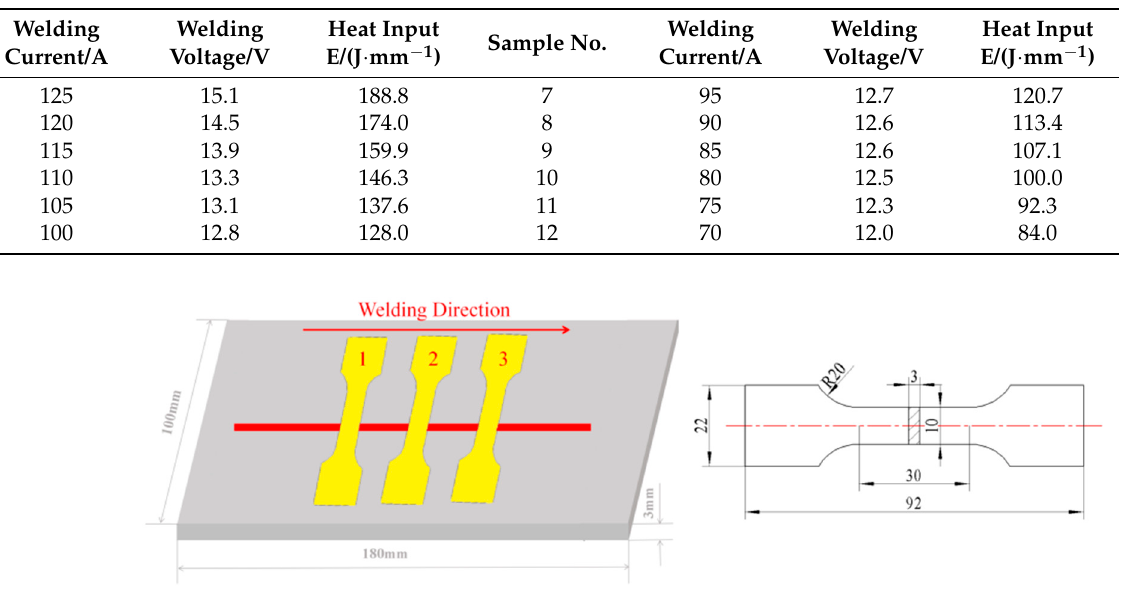
Figure 1. The CMT welding equipment. Table 1. Chemical compositions of 2A14 aluminum alloy and ER2319 filler metal (wt. %). Table 2. Weld parameters of 2A14 aluminum alloy and ER2319 filler metal.